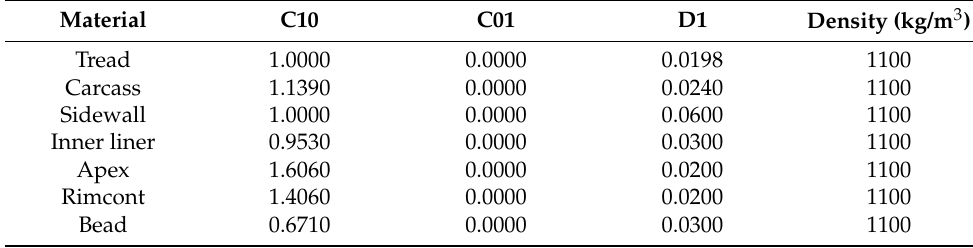
Table 1. Rubber material parameter